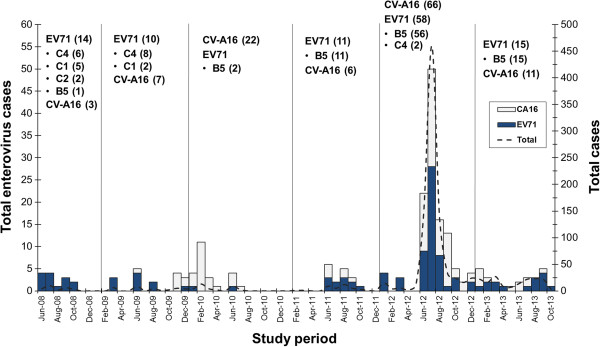
Successive appearance and distribution of predominant types and genotypes of enterovirus between 2008 and 2013. Numbers of cases are indicated after types and genotypes of viruses.